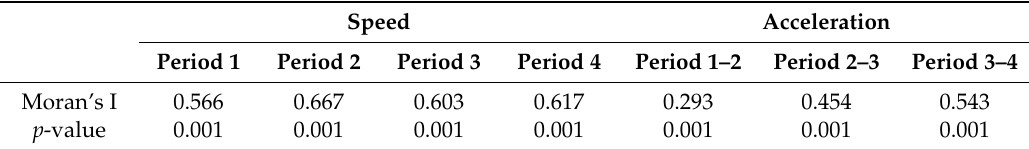
Table 3. Moran’s I index of expansion speed and acceleration in di ff erent